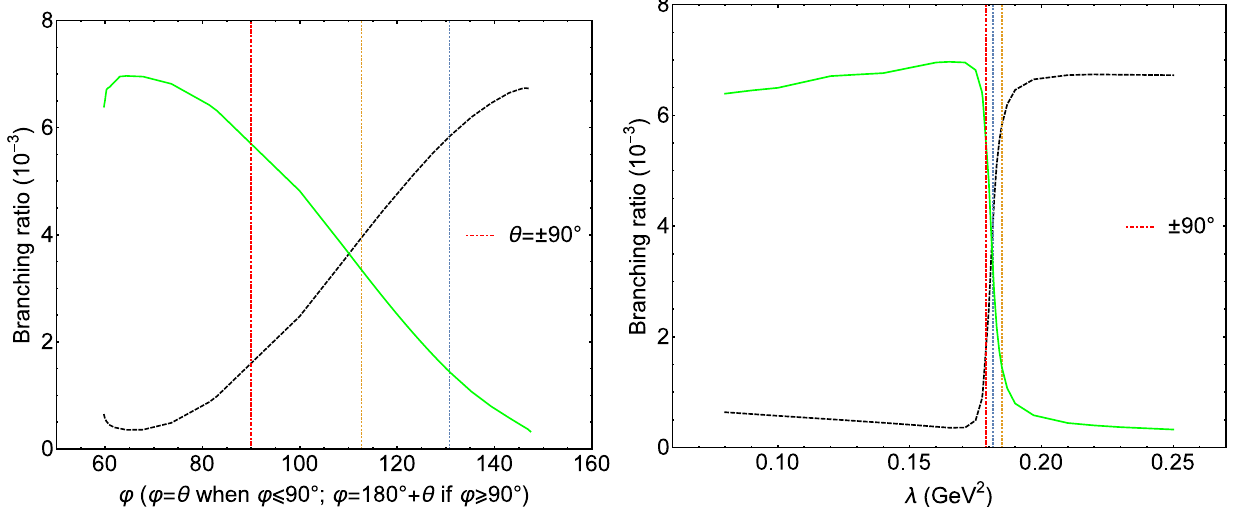
Fig. 3 The branching ratios Br ( B → D 1 (cid:4)ν (cid:4) ) (black dashed line) and Br ( B → D (cid:3) the range of our best